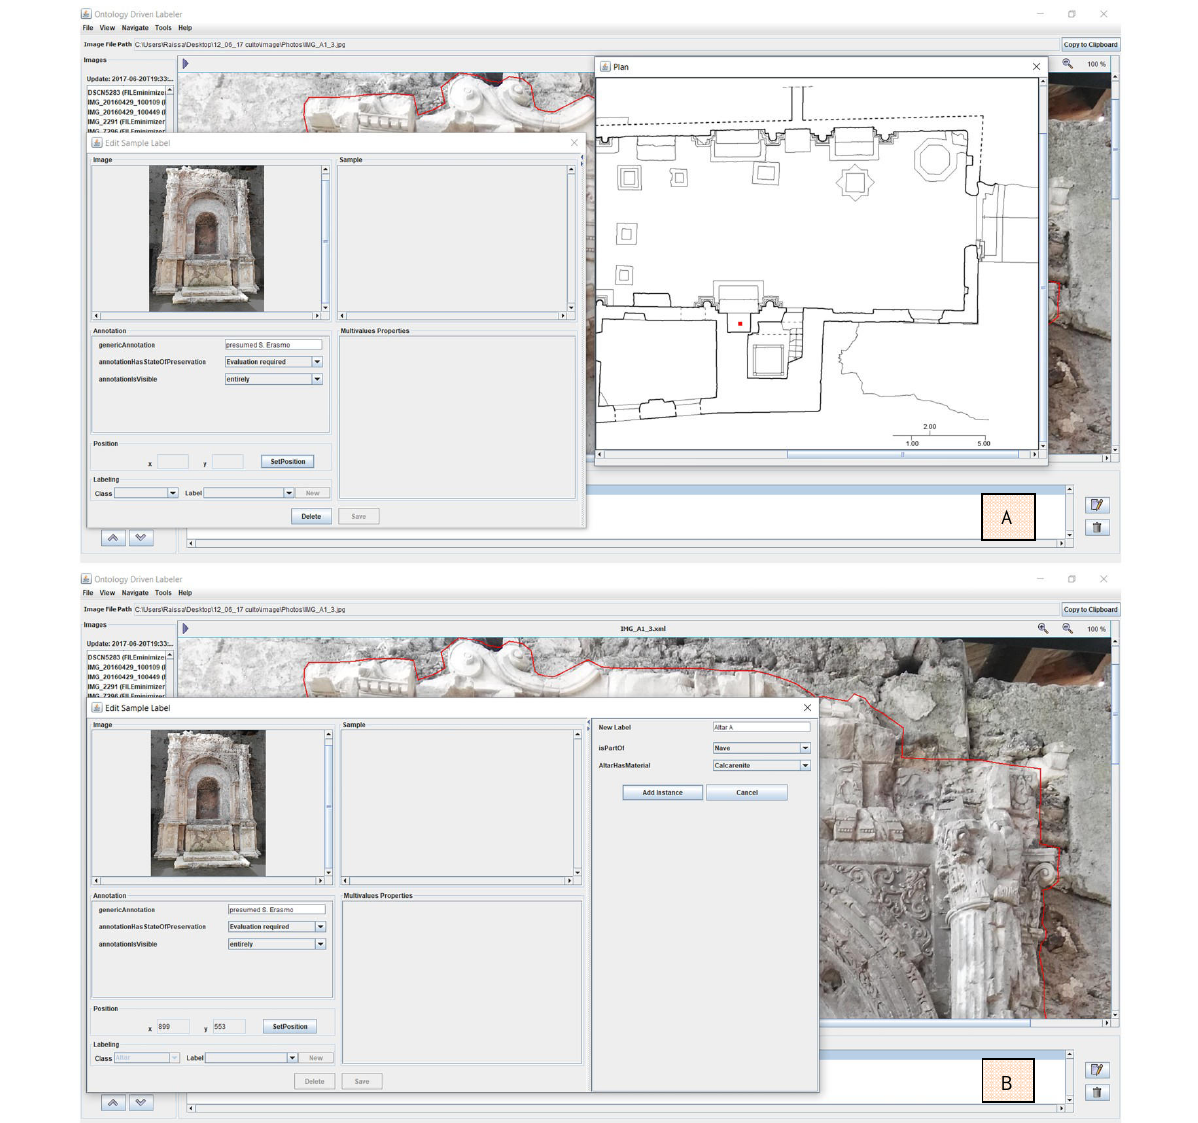
Figure 7. A: the user is prompted with a dialog box where he is able to tag the finding position with a red dot. B: once the user has selected the class Altar and clicked the “New” button, the dialog box allows the user to add a new instance in the current ontology and specify all its attributes (e.g. the altar